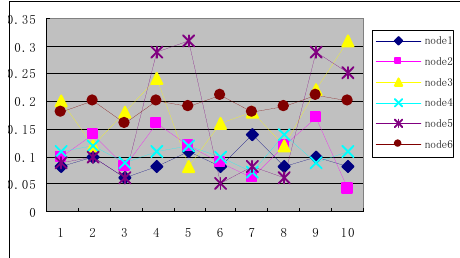
Fig.1. Package losing rate curve